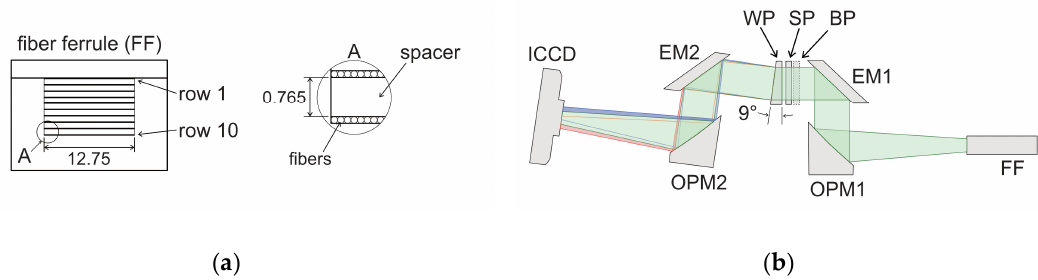
Figure 5. ( a ) Arrangement of stacked fiber rows; ( b ) optical layout of the relay optic between the fiber output and the image intensified charged coupled device (ICCD) camera. The signal of each individual optical fiber was spatially separated into its wavelengths by a prism and imaged onto the camera. (FF: fiber ferrule, OPM: off-axis parabolic mirror, EM: flat-elliptical mirror, BP: band-pass filter (optional), SP: short-pass filter, WP: wedged prism).